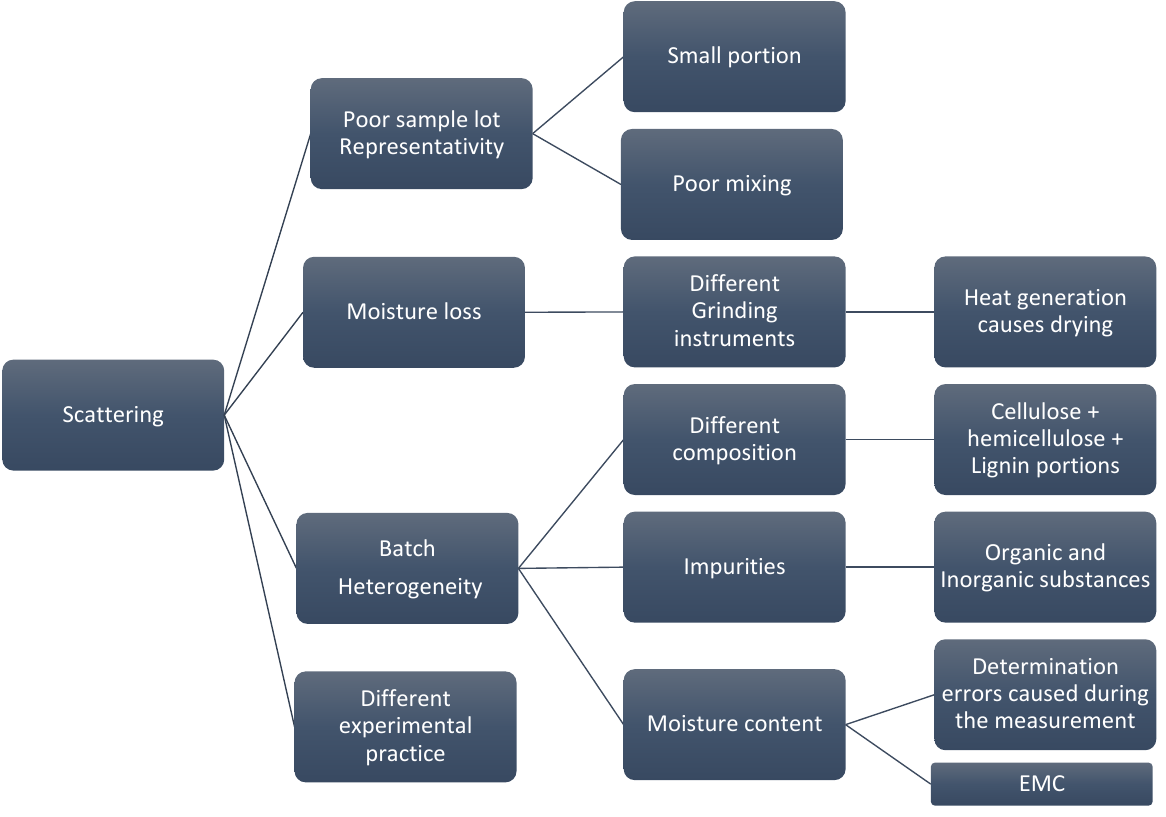
Figure 2. Root cause analysis of possible reasons behind the data scattering.